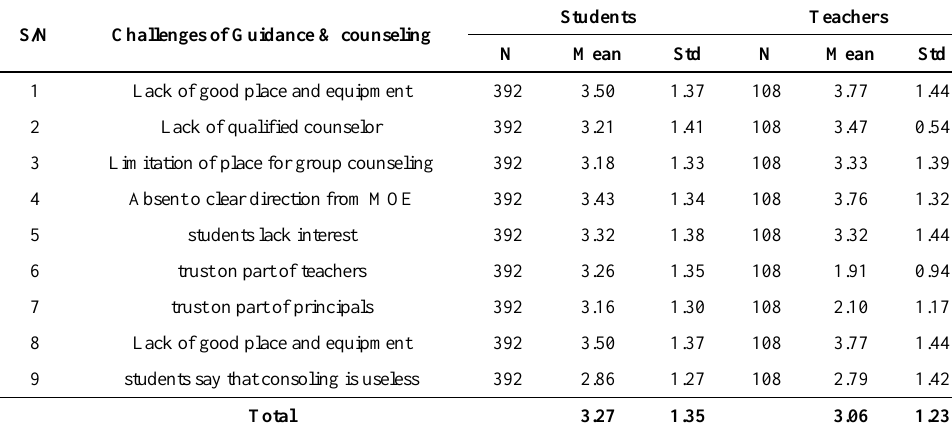
Table 5. Challenges of guidance and counseling